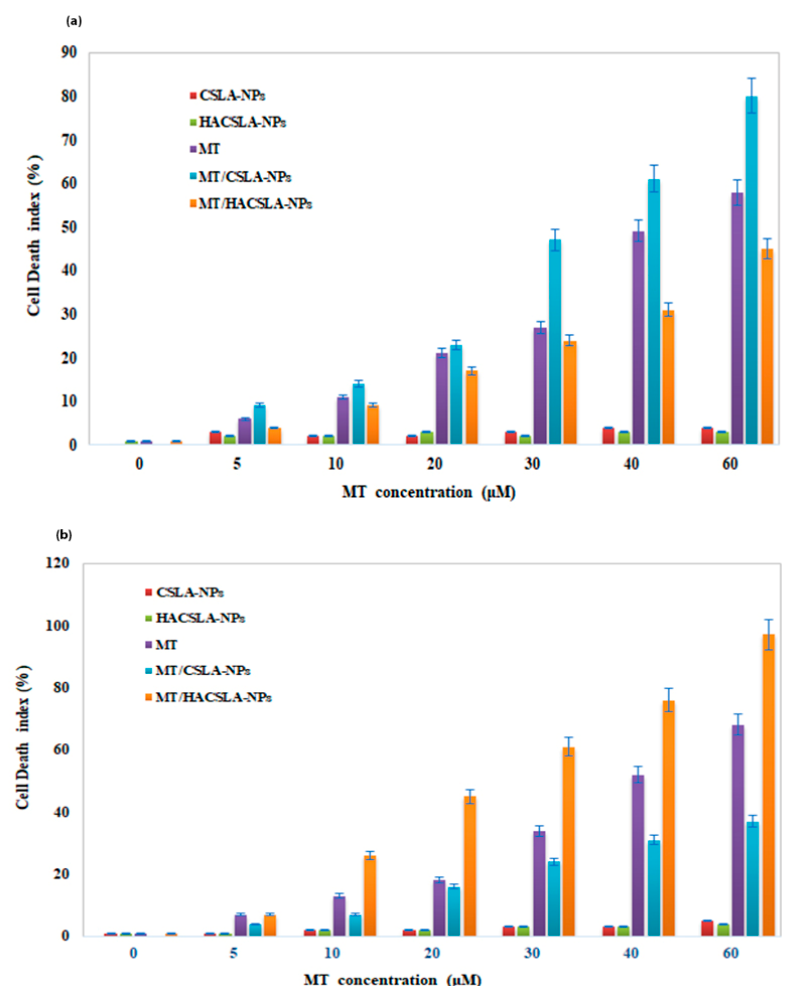
Figure 8. MT cytotoxicity measured with the Terminal deoxynucleotidyl transferase dUTP nick end labeling (TUNEL) assay in ( a ) MCF-7 and ( b ) BT-20 cells. All data represented by mean ± S.E.M ( p < 0.05).